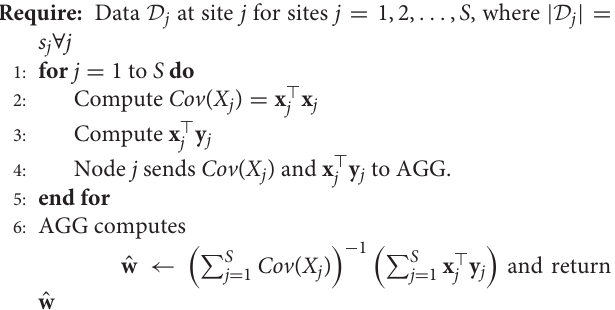
Algorithm 2 Decentralized Regression with Normal Equation